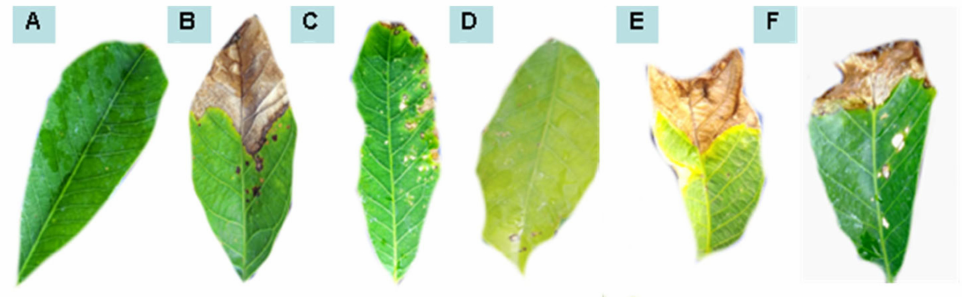
Figure 3. Leaf area affected by anthracnose after preventive treatments with water ( A ), Colletotrichum alone ( B ), P. macrosporus —Isolate 37/06 ( C ), C. eragrostidi —Isolate 47/06 ( D ), M. levispora —Isolate 33/08 ( E ), and M. roridum —Isolate 03/10 ( F